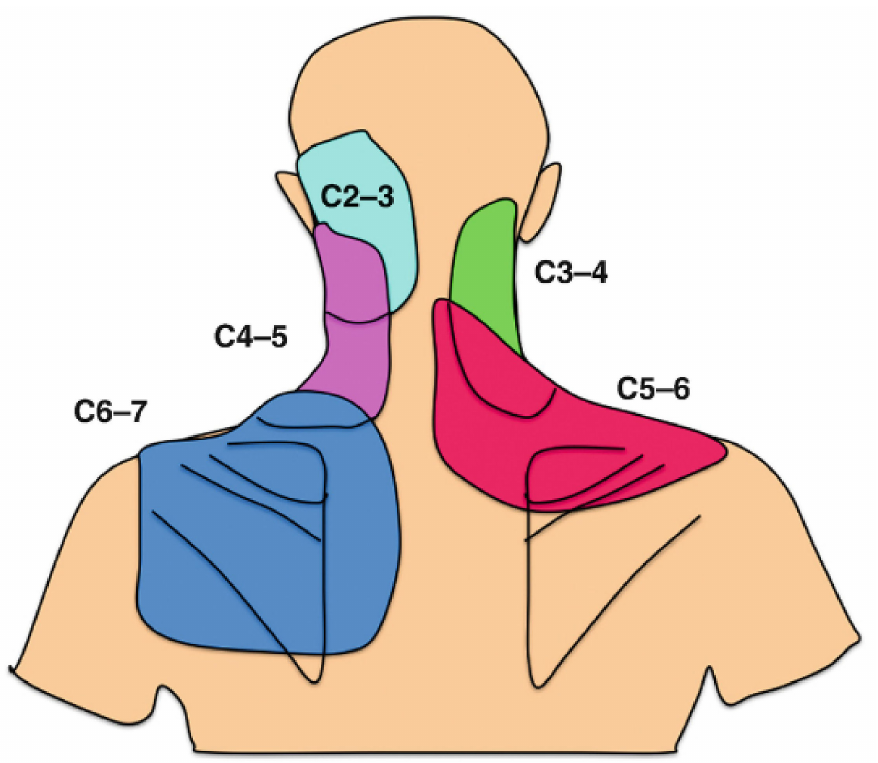
Figure 1. Illustration in which the volunteers pointed to the region of their pain (adapted from Dwyer et al. 1990